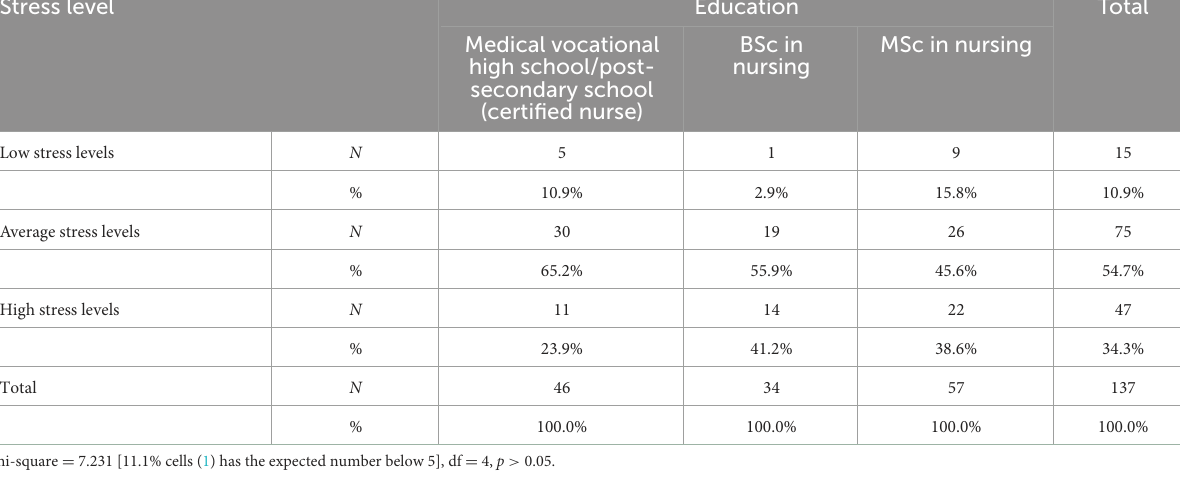
TABLE 5 Completed postgraduate training and the level of perceived